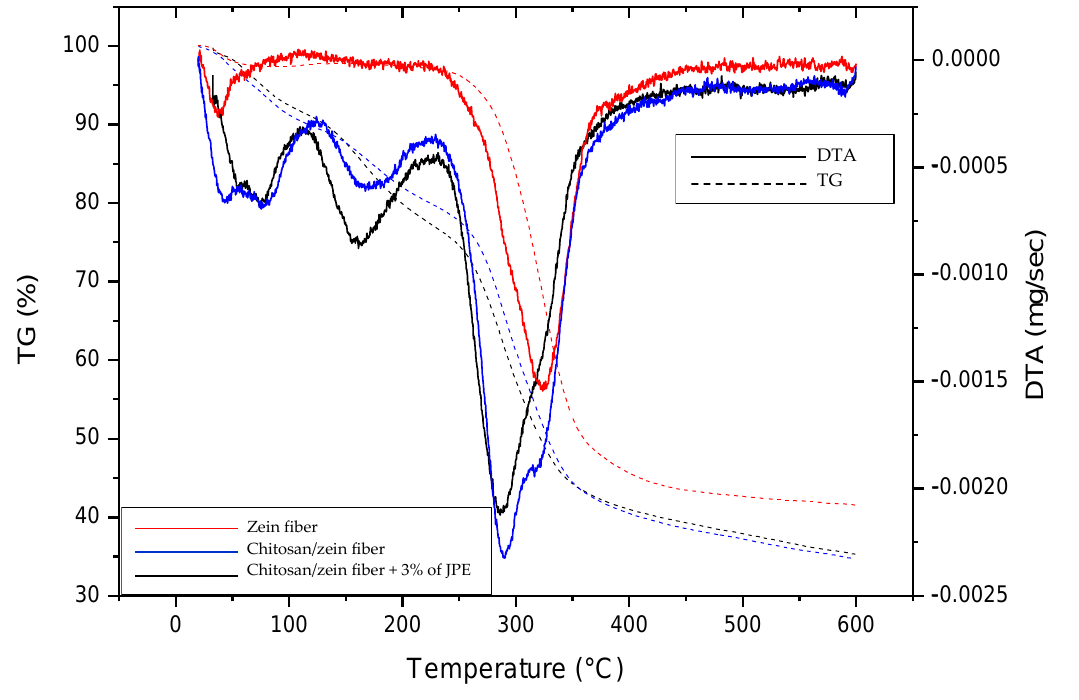
Figure 5. TG and DTA curves of zein fiber, chitosan/zein fiber, and chitosan/zein fiber + 3% of JPE. The degradation stages show differences between the zein fiber and bilayer films.